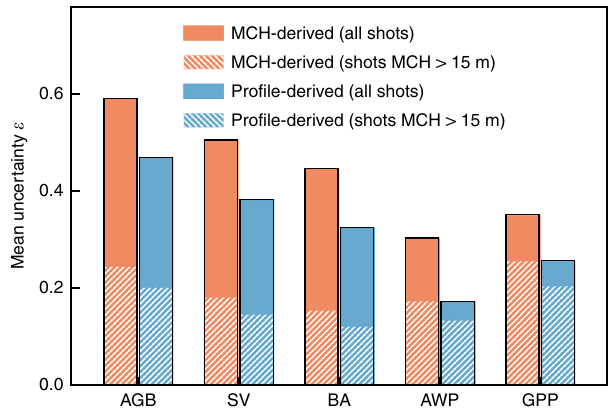
Fig. 4 Mean uncertainties ε for different forest attributes. Shown are ε for aboveground biomass (AGB), stem volume (SV), basal area (BA), aboveground wood productivity (AWP), and gross primary productivity (GPP) taking mean canopy height (MCH) as a proxy for forest attributes (MCH-derived) vs. the entire lidar pro fi le (pro fi le-derived). Hatched bars show the mean uncertainty index for lidar pro fi les with a MCH > 15 m. Source data are provided as a Source Data fi